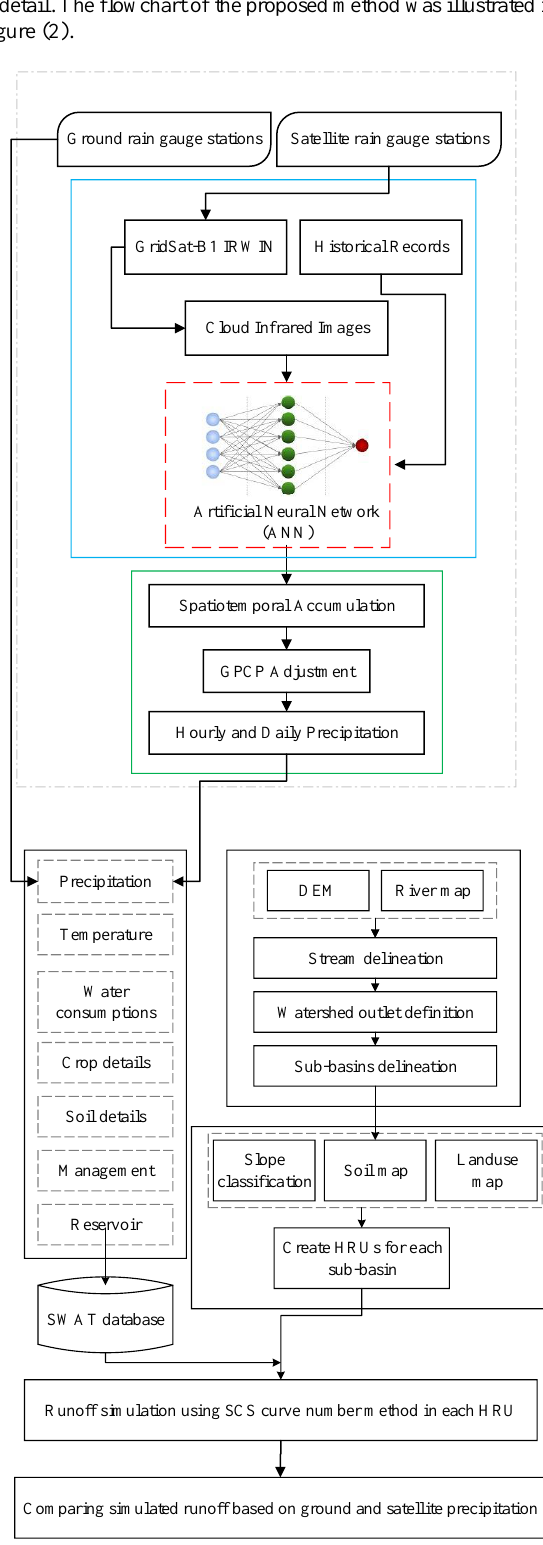
Figure 2. Flowchart of the proposed method for comparing simulated runoff based on SPPs and GRGs